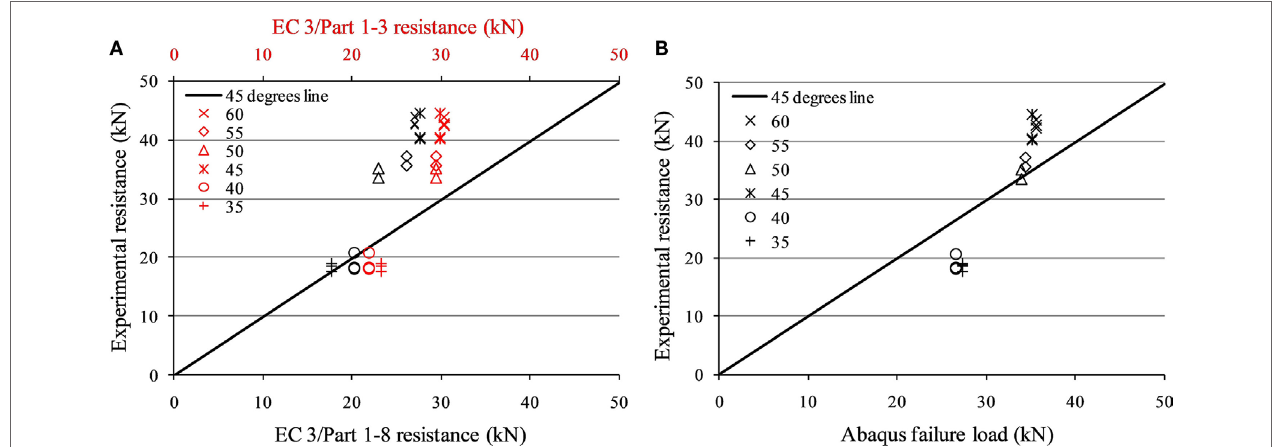
FiGUre 2 | Comparison of tension experimental results with (A) the EN 1993 provisions (B) the numerical analyses. FiGUre 3 | Comparison of compression experimental results with the predictions of (A) the EN 1993-1-1, (B) the EN 1993-1-3, (c) the EN1993 for compression only, and (D) with the numerical analyses.